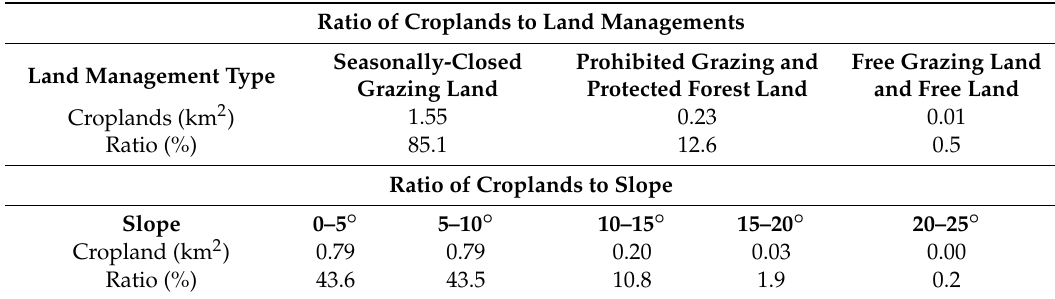
Table 2. Spatial distribution of croplands by the land management and slope in Adi Zaboy